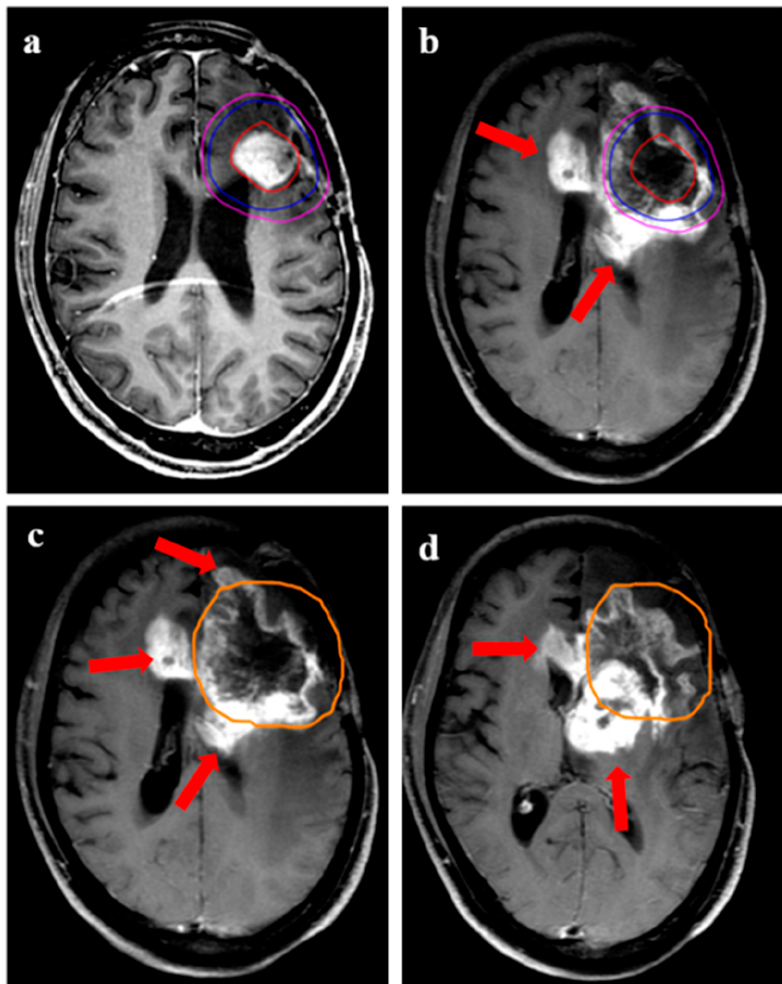
Figure 6. Demonstration of marginal recurrence following re-irradiation for a 43-year female with transformed high-grade glioma. ( a ) shows the target volumes (GTV: red, CTV: blue; PTV: magenta) on T1w contrast MRI. The GTV was the enhancing disease, with CTV drawn as an expansion of 10 mm around the enhancing disease. ( b , c ) demonstrates recurrent disease (arrows) with respect to target volumes and 95% isodose line (orange), 1. ( d ) is a representation from lower axial slices showing the growth of recurrent disease further beyond the 95% isodose line.